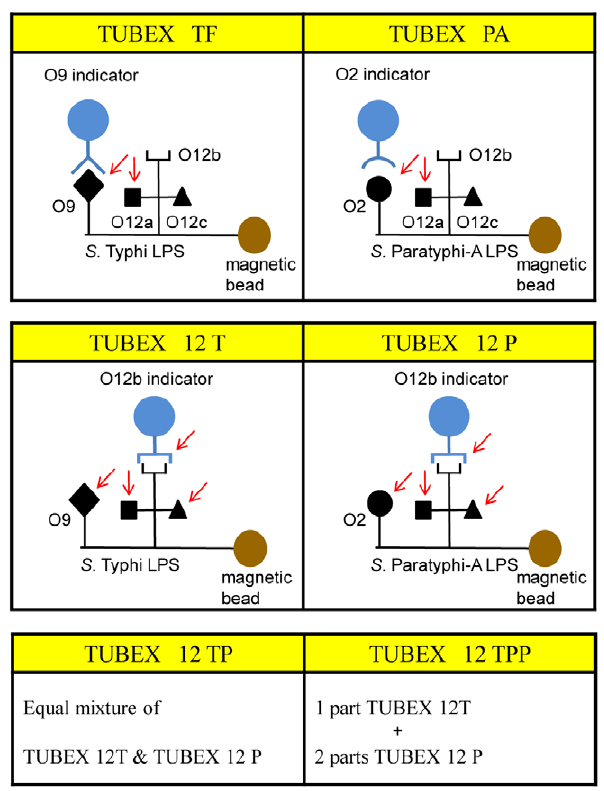
Figure 1. Schematic diagram illustrating the various types of TUBEX tests and the various types of antibodies detected by these. Shown are the various mAb-indicators (anti-O9, anti-O2 or anti- O12b) and antigenic epitopes (O9, O2 O12a, O12b and O12c) found in S . Typhi or S . Paratyphi A LPS. Arrow indicates antigenic epitope that antibodies from patients presumptively bind to and inhibit binding of the indicator particle.